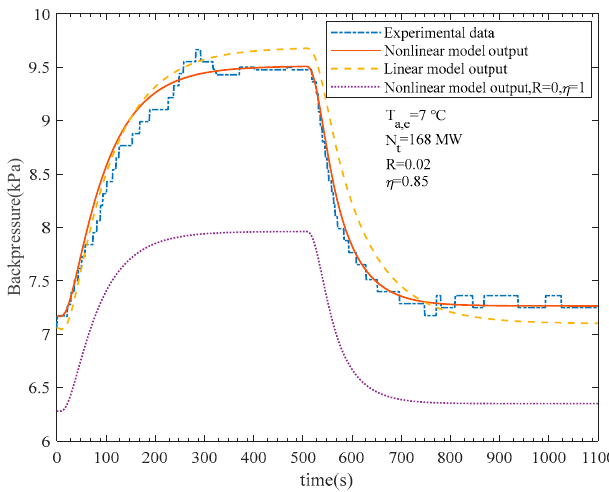
Figure 4. Experimental and simulation results of fan speed step test.